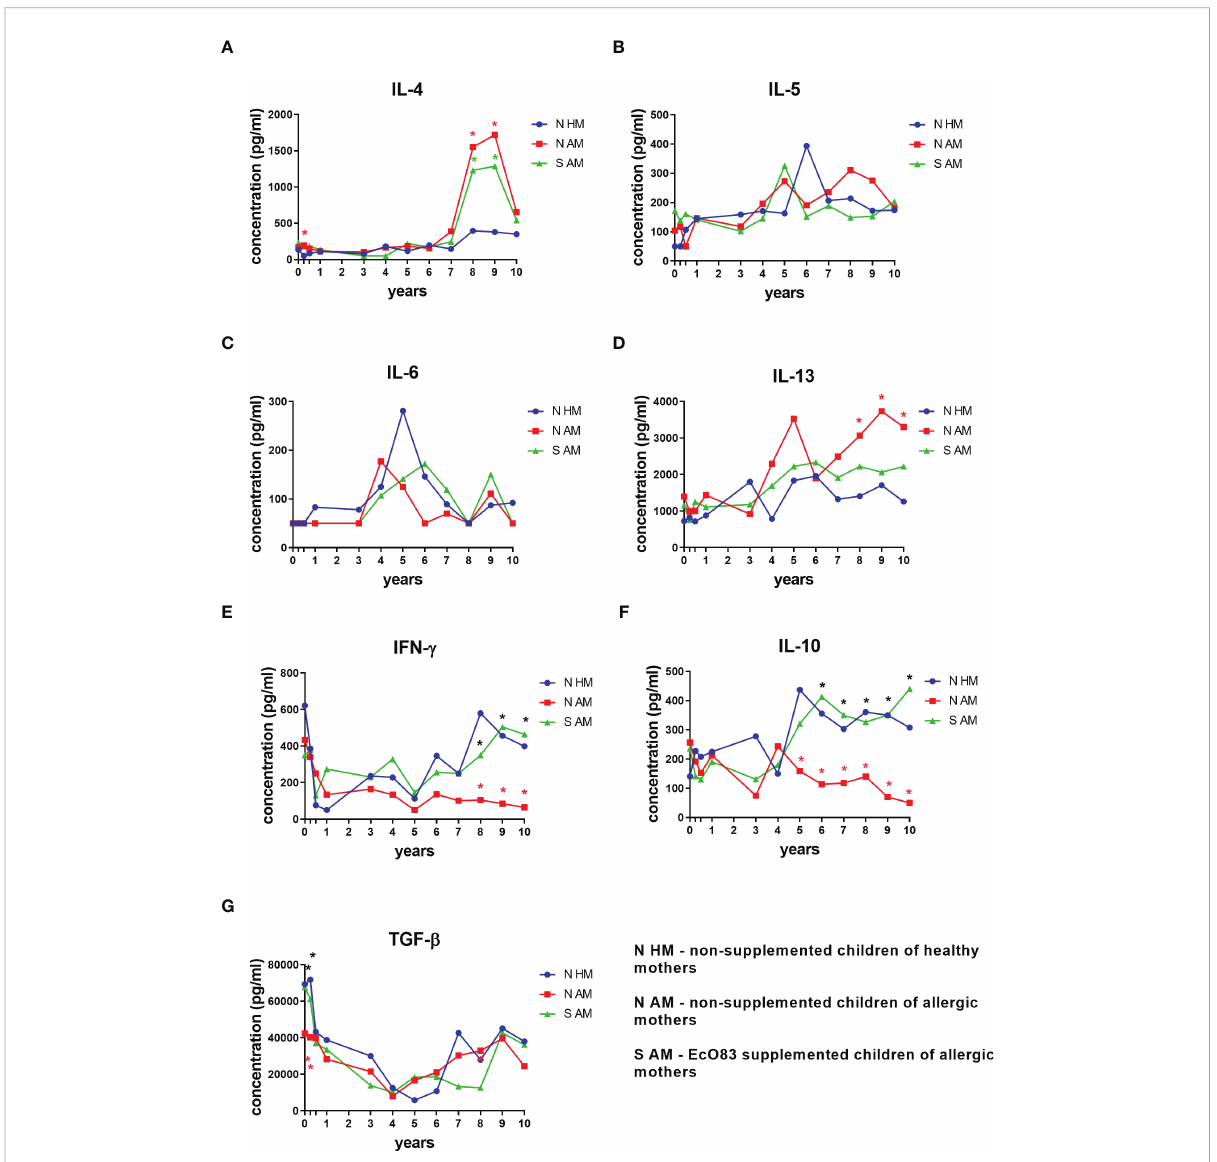
FIGURE 1 Cytokine concentration in cord and peripheral blood sera of children until the age of 10 years. Cytokines were determined by ELISA. Typical Th2 cytokines were determined: IL-4 (A) , IL-5 (B) , IL-6 (C) , and IL-13 (D) . The concentration of typical Th1 cytokine (IFN- g ) is shown in (E) Dynamics of concentration of immunoregulatory cytokines is presented in (F) for IL-10 and panel (G) for TGF- b . EcO83, Escherichia coli O83:K24:H31; *p ≤ 0.0071 (adjusted p value). IL, interleukin; IFN, interferon; TGF, transforming growth